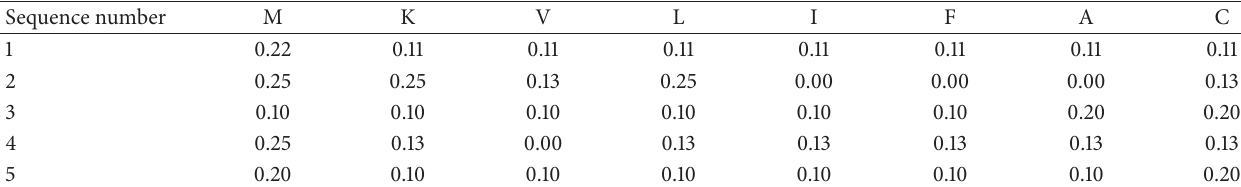
Table 1: The frequency of 𝑋 1 (single letter amino acid descriptors) for each sequence. Sequence number